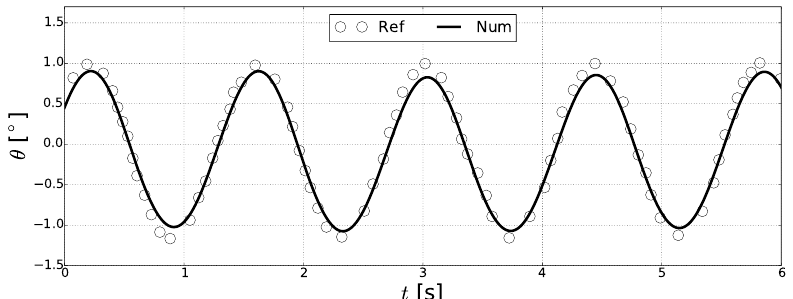
Figure 20. Numerical solution for the pitch motion over time with regular waves. The numerical reference solution was taken from